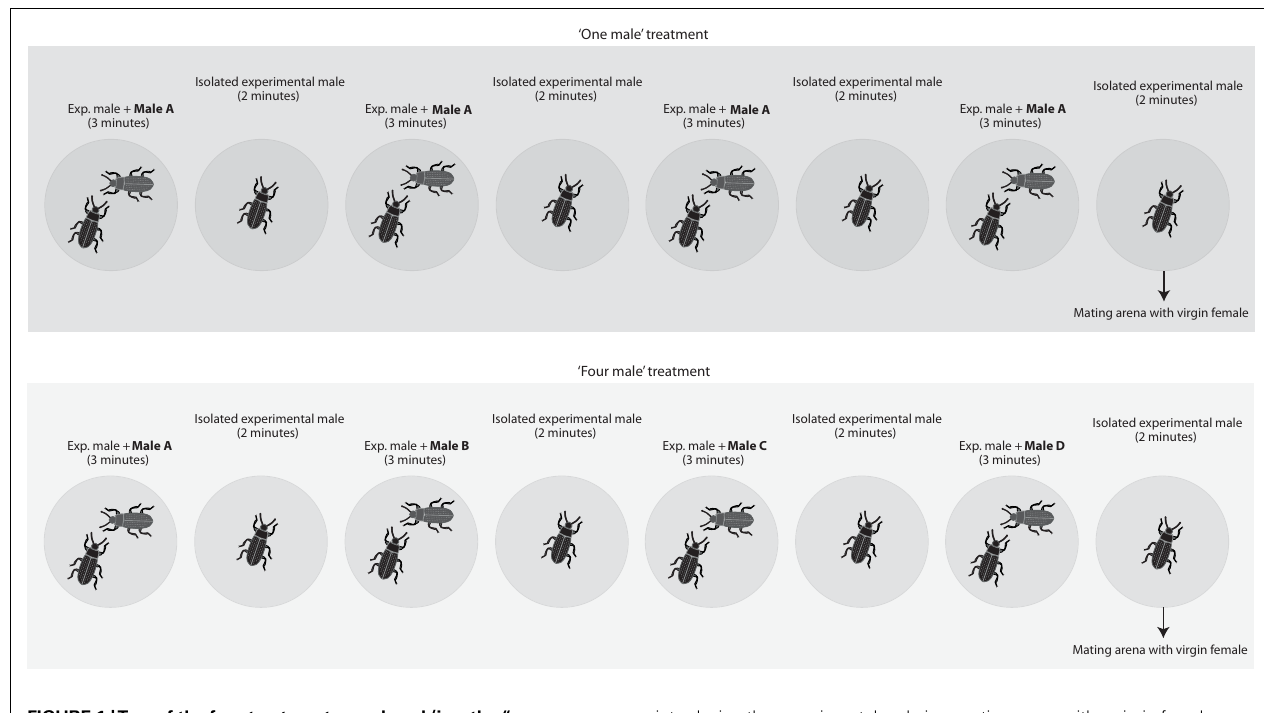
FIGURE 1 |Two of the four treatments employed (i.e., the “one male” and the “four males” treatments) as an example to illustrate the experimental designed used. We staged matings between virgin females and virgin males in which we varied the number of rival males the experimental male had access to immediately preceding matings. Each male was introduced in a small 5cm diameter arena with another male for 3min and then isolated in a new blank arena for 2min.We repeated this protocol four times in a row (i.e., overall 20min) before